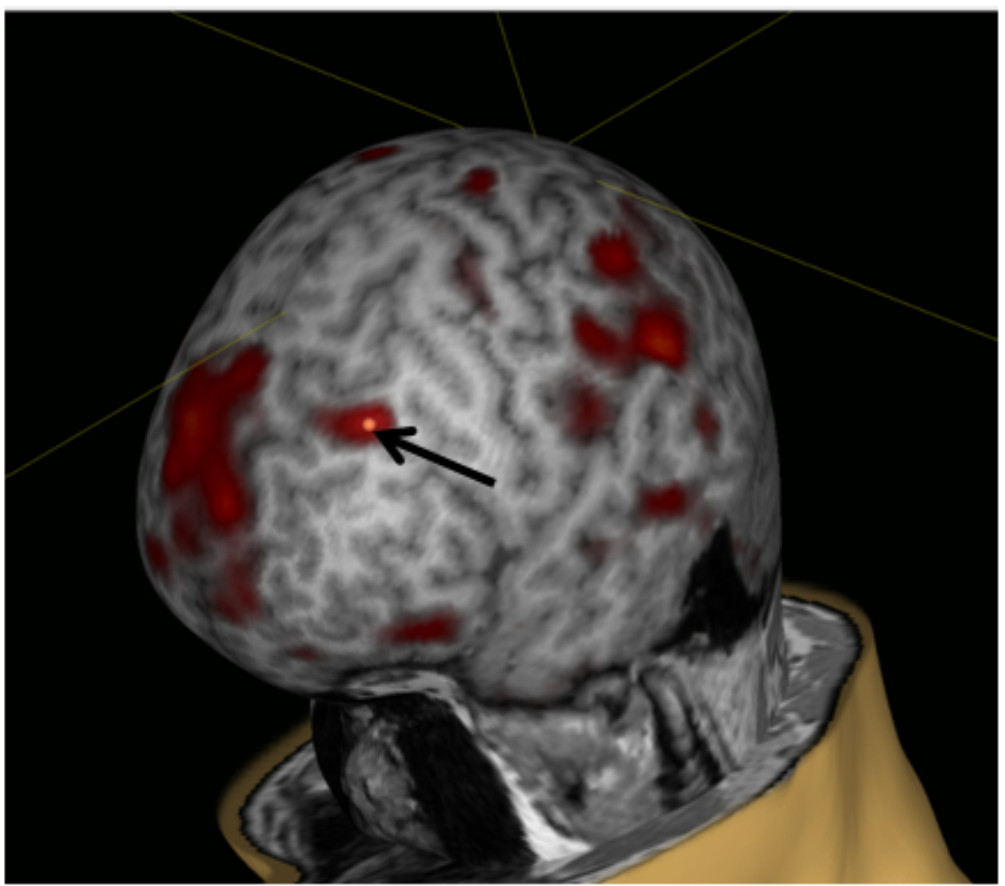
Figure 3. Example of the stimulation target for rTMS over left DLPFC in a healthy volunteer.